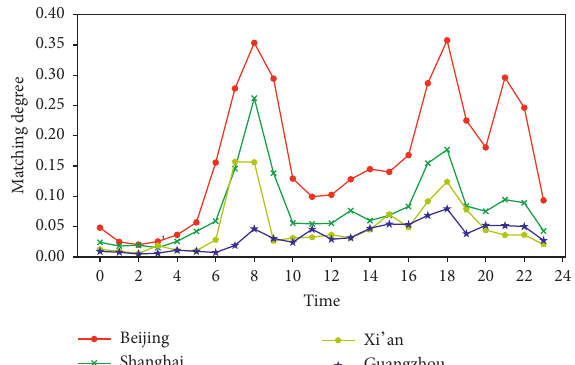
Figure 4: From top to bottom, the lines represent the average matching degree of Beijing, Shanghai, Xi’an, and Guangzhou in 24 hours of one day. This diagram indicator can measure the degree of matching between passengers and taxis at the current moment.